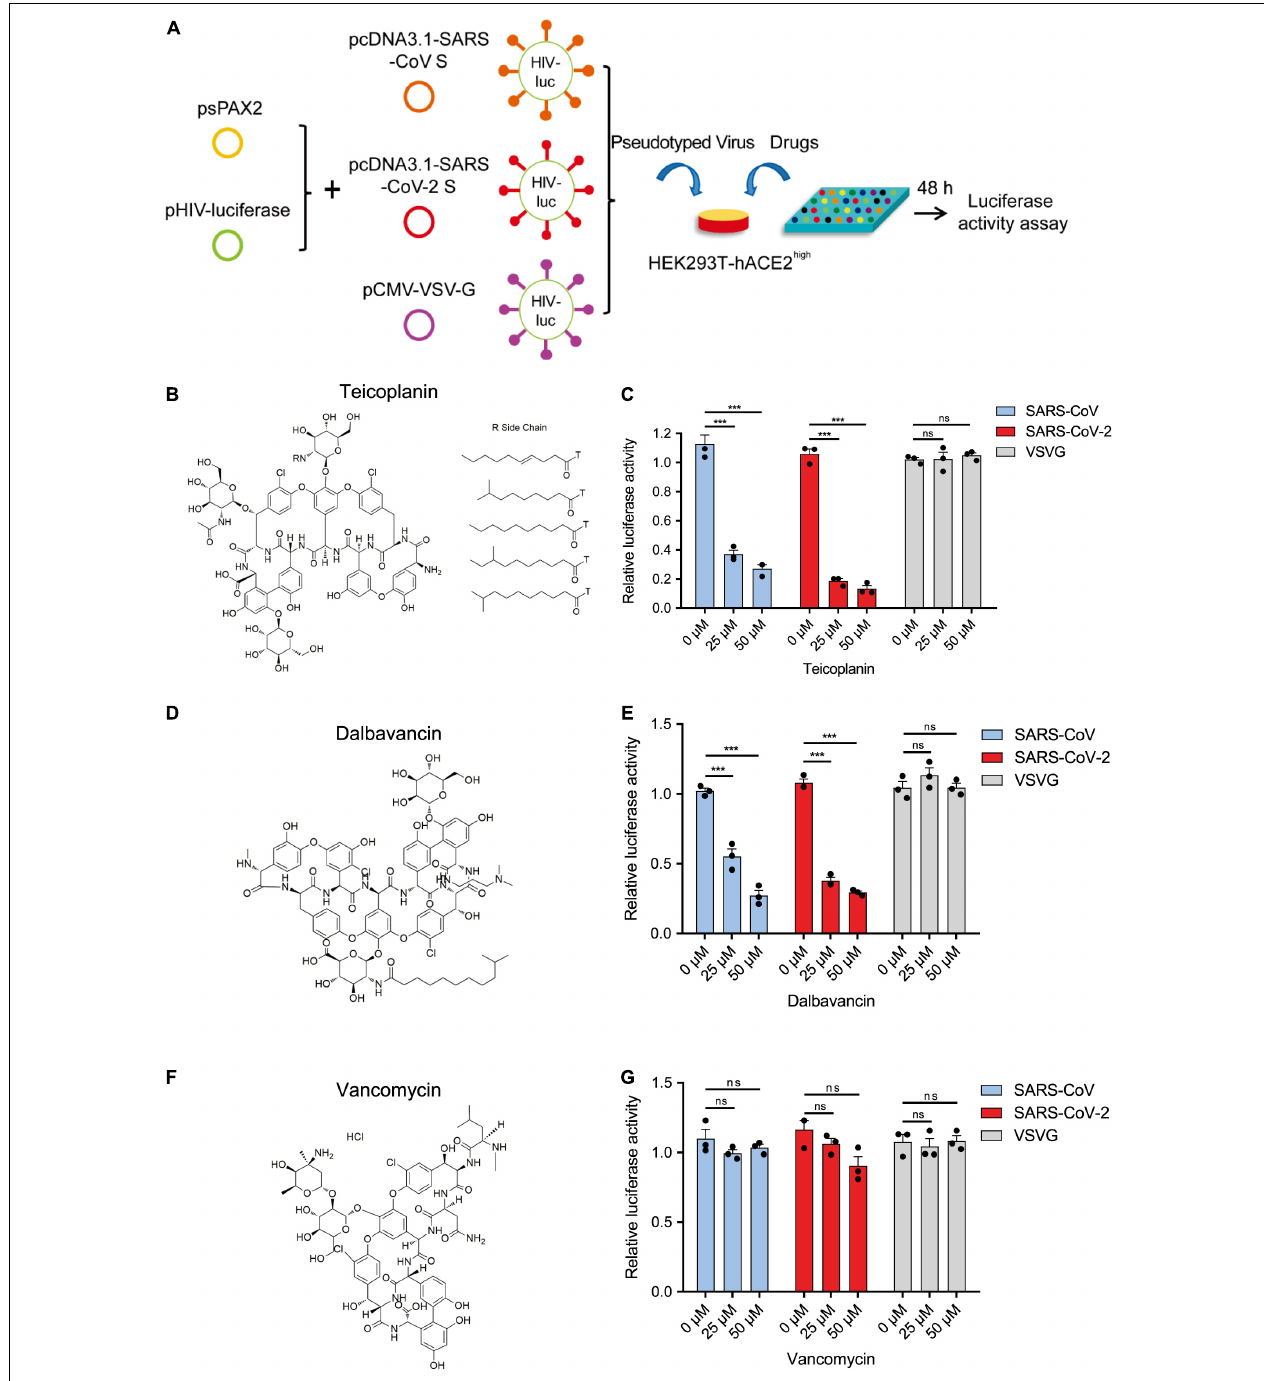
FIGURE 2 | Teicoplanin specifically inhibited the entry of pseudotyped SARS-CoV-2. (A) Schematic of the pseudotyped virus entry upon drug treatment assay. To package different pseudotyped viruses, psPAX2 plasmids, and pHIV-Luciferase plasmids were co-transfected into HEK293T cells with pcDNA3.1-SARS-CoV S, pcDNA3.1-SARS-CoV-2 S, and pCMV-VSV-G plasmids, respectively. HEK293T-hACE2 high cells were incubated with drugs and different pseudotyped viruses. The amounts of luciferase within cells were measured 48 h post infection. (B) Chemical structure of teicoplanin. (C) HEK293T-hACE2 high cells were treated with 0, 25, and 50 µ M teicoplanin, respectively, followed by infecting with different pseudotyped viruses including SARS-CoV S/HIV-1, SARS-CoV-2 S/HIV-1, and VSV-G/HIV-1. The intracellular luciferase activity was measured 48 h post infection ( n = 3). (D) Chemical structure of dalbavancin. (E) HEK293T-hACE2 high cells were treated as in (C) , except that the drug was replaced with dalbavancin ( n = 3). (F) Chemical structure of vancomycin. (G) HEK293T-hACE2 high cells were treated as in (C) , except that the drug was replaced with vancomycin ( n = 3). Data in (C,E,G) represented as mean ± SEM in triplicate. P -values were calculated by two-way ANOVA with Dunnett’s multiple comparisons test which compared the mean of each group with the mean of the control group. ns p ≥ 0.05, *** p < 0.001.